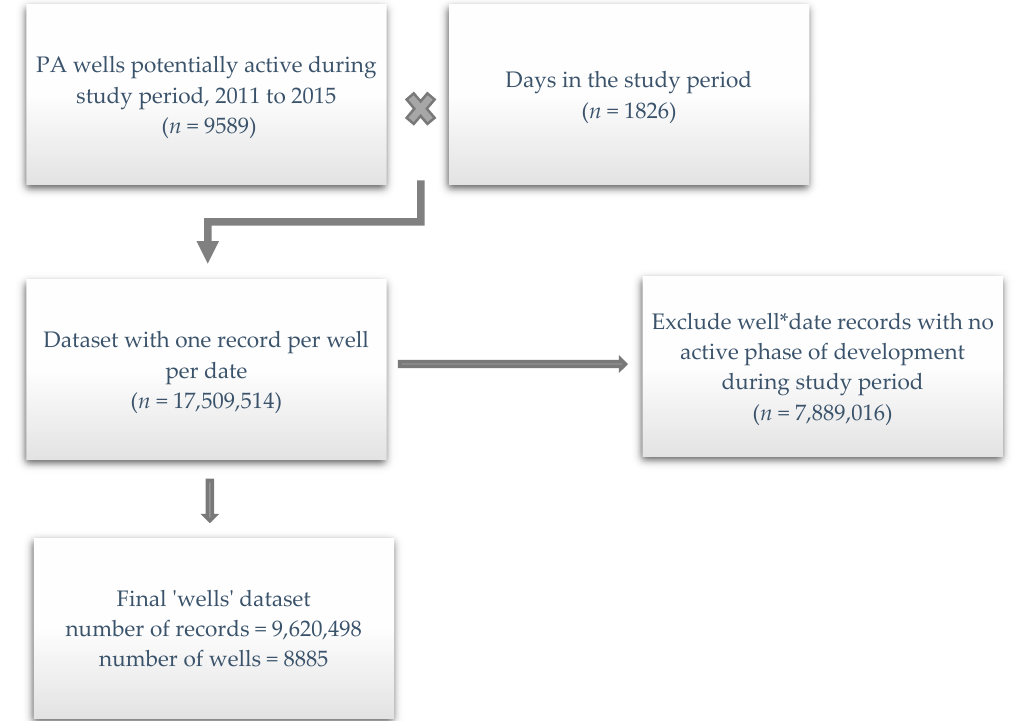
Figure 1. Description of process used to compile final wells dataset for